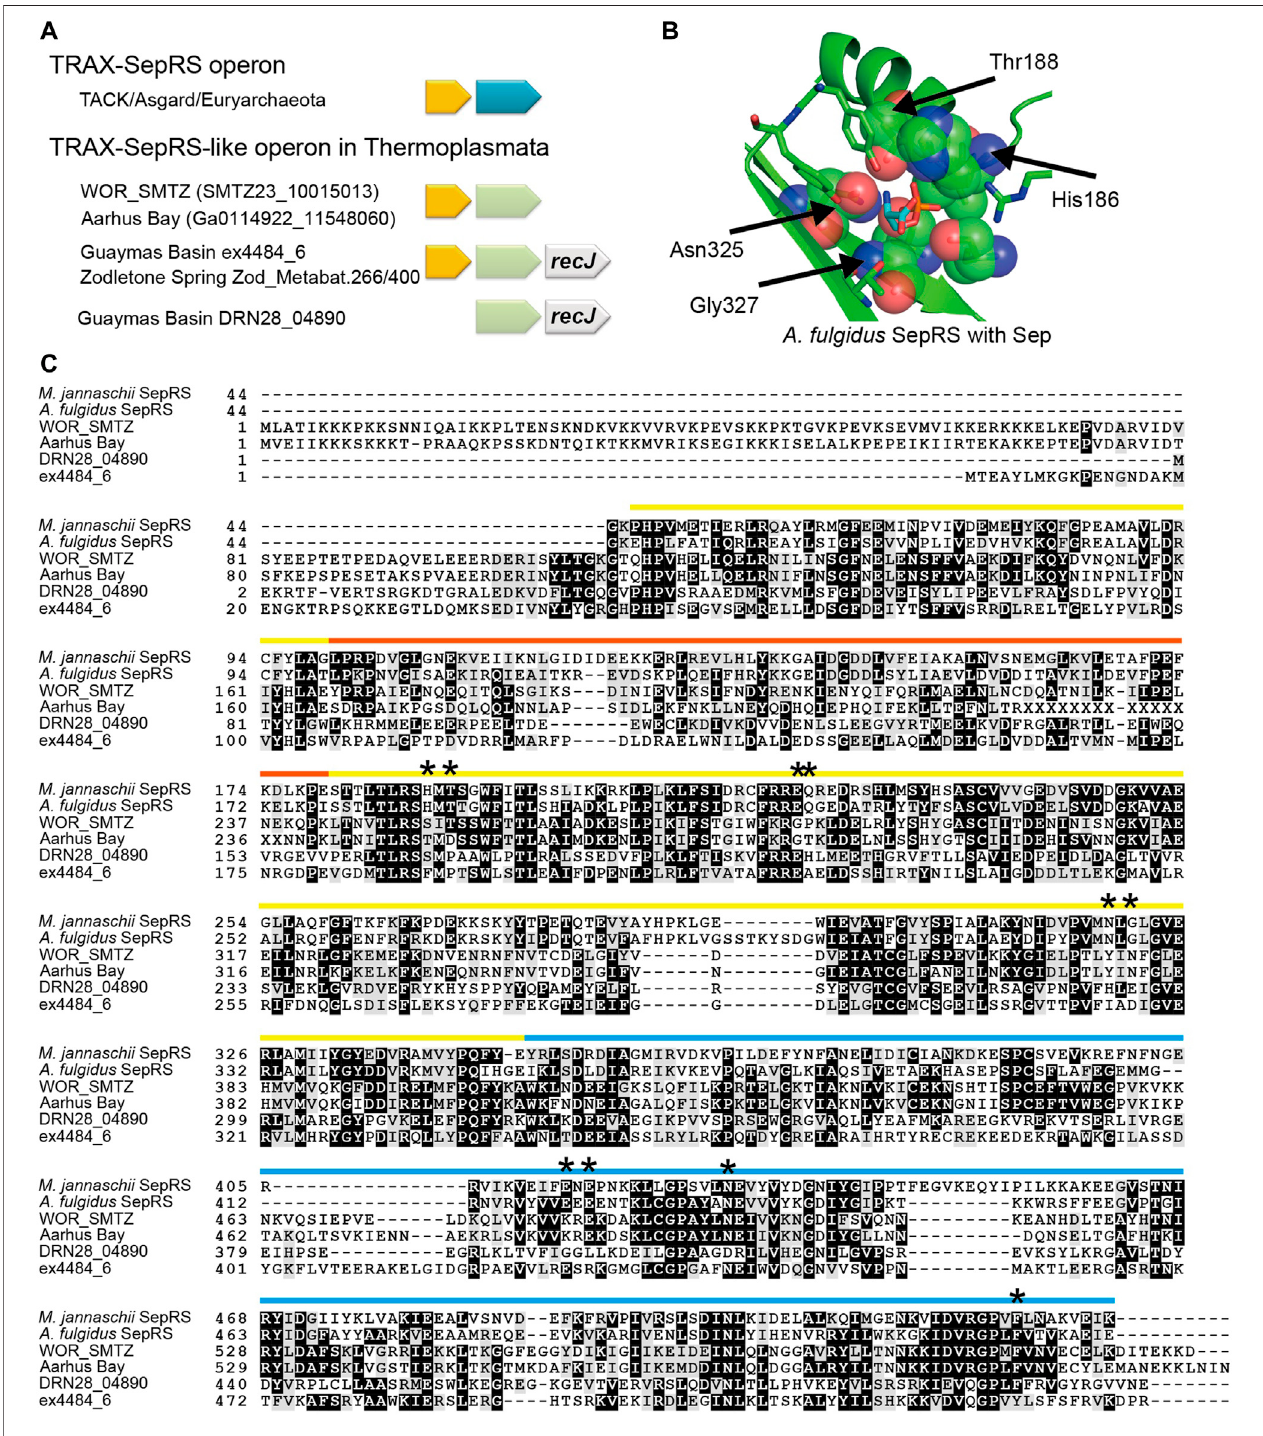
FIGURE 6 | Characterization of SepRS-like proteins from two lineages of Thermoplasmata archaea (A) The operon structures of the four SepRS-like genes identi fi ed. Like many SepRS genes, three SepRS-like genes are headed by a TRAX homolog gene. In the Guaymas Basin hydrothermal vent lineage and the Zodletone Spring lineage, the SepRS-like genes are followed by a predicted recJ gene (B) The four residues important for Sep recognition by SepRS are altered in SepRS-like proteins (C) Multiple sequence alignment of SepRS-like proteins with two reference SepRS proteins. Interesting mutations are denoted by stars. The color bars represent the domain structure and follow the same scheme as in Figure 3 , with the yellow bar denoting the catalytic domain, the orange bar denoting the inserted domain, and the blue bar denoting the anticodon binding domain. A part of the Aarhus Bay SepRS-like sequence remains elusive (indicated with Xs).